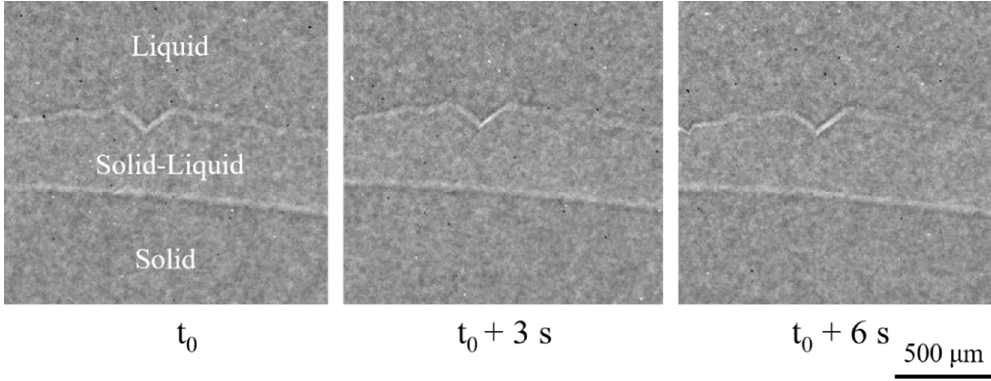
Figure 4. X-ray radiography images recorded during solidification, applied temperature gradient: 30 K/cm and cooling rate = − 1 K/min applied on both heaters. Typical facetted/facetted grain boundary groove revealed by division by successive images.